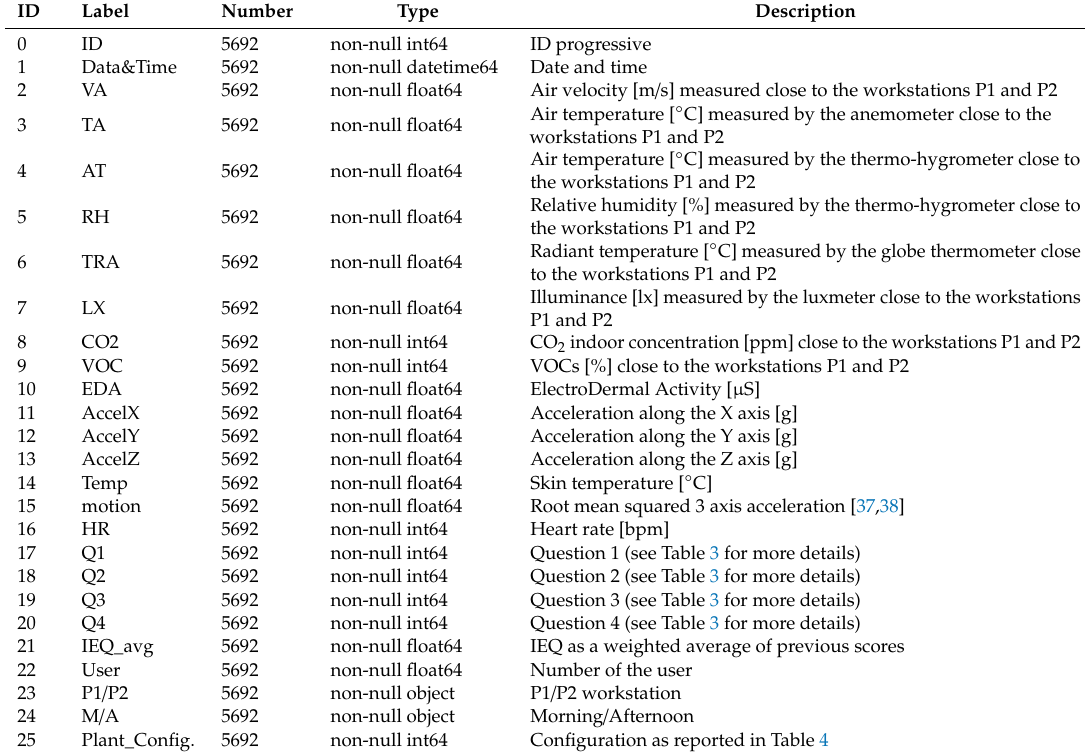
Table 5. Dataset attributes and